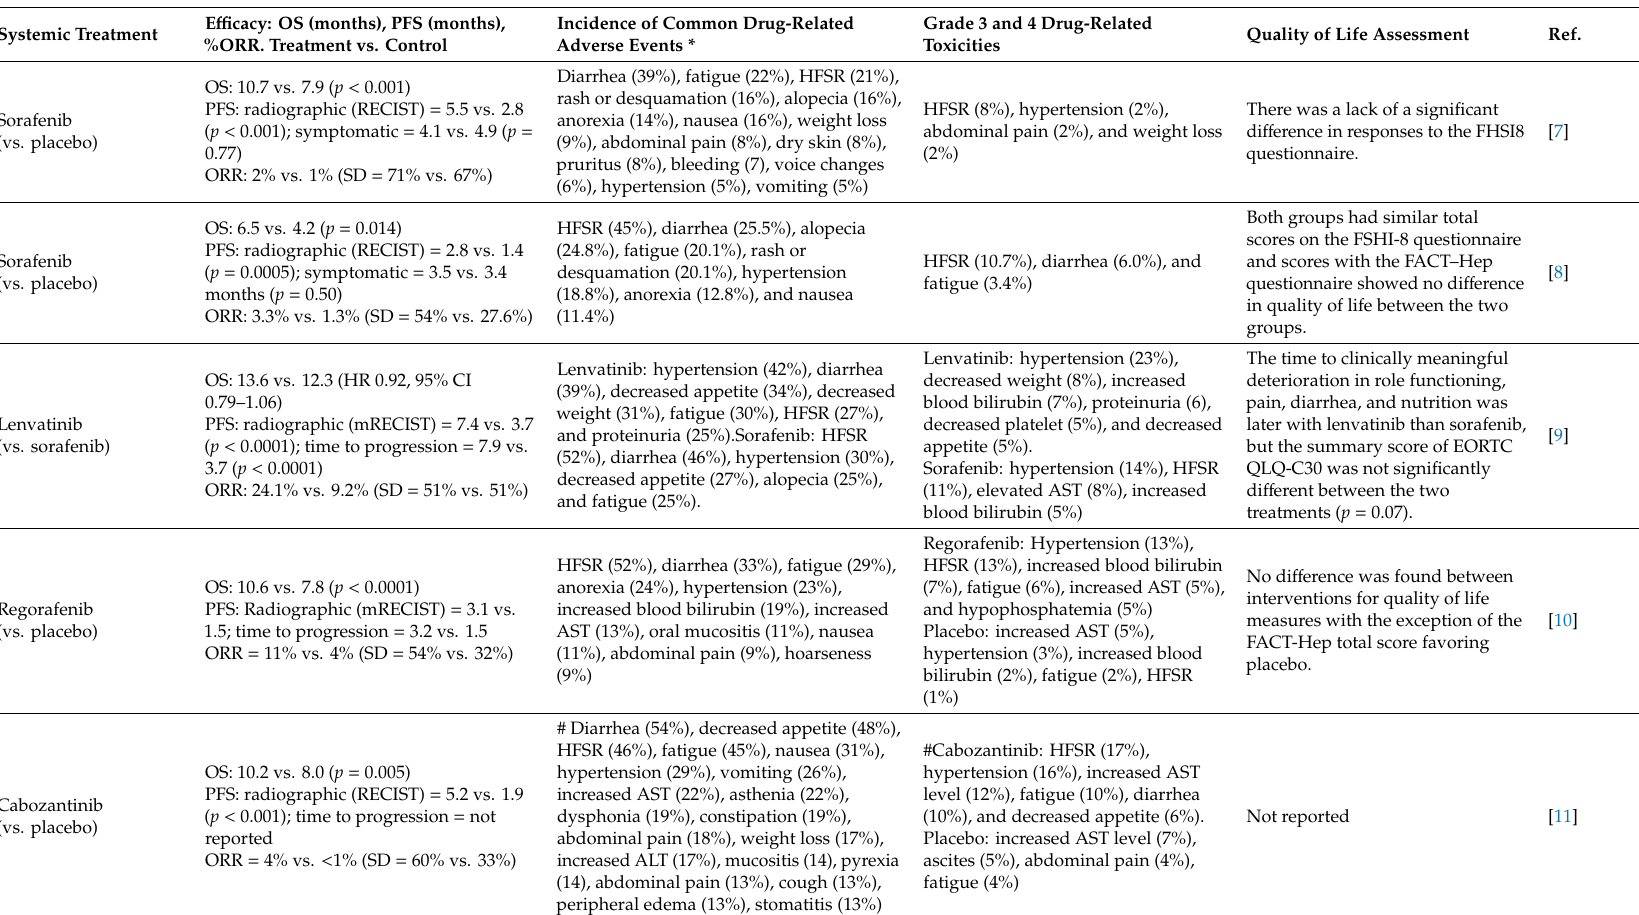
Table 1. A summary of outcomes, side e ff ects, and quality of life in systematic treatments of hepatocellular carcinoma. E ffi cacy: OS (months), PFS (months), Incidence of Common Drug-Related Systemic Treatment %ORR. Treatment vs. Control Adverse Events *